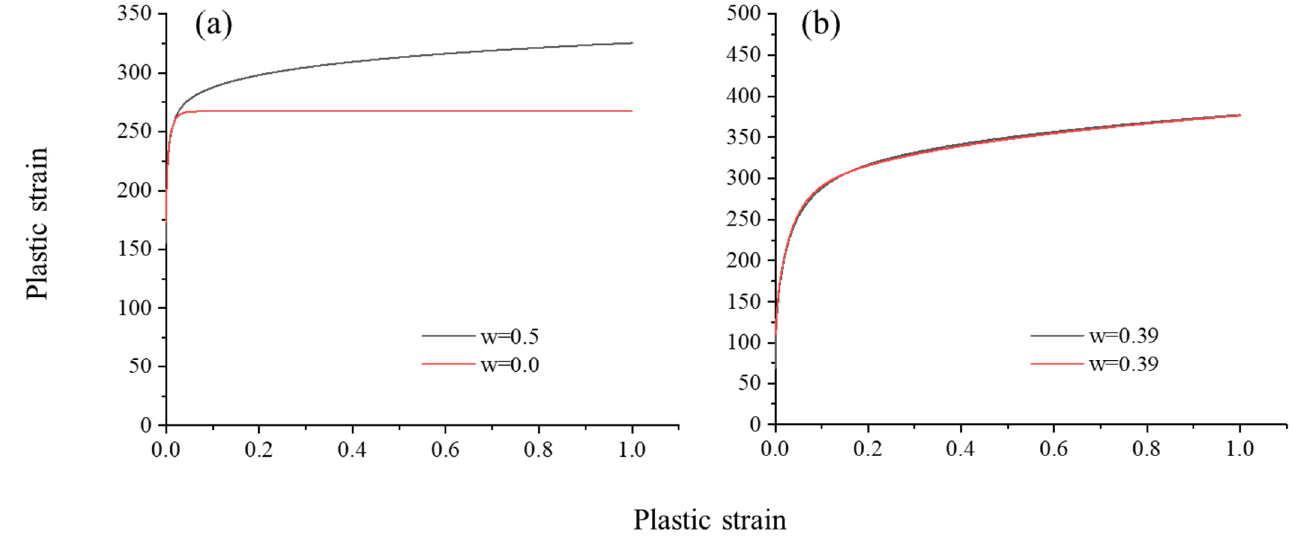
Figure 14. Extrapolating curves of tetrahedral-based models for ( a ) MAT 1 and ( b ) MAT 3.